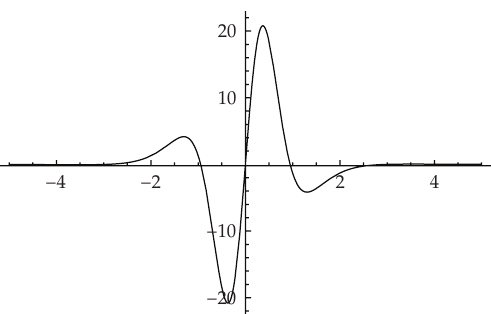
Figure 4: Graph of the conjugate fractional derivative v 3 . 8 (cid:3) X (cid:4)